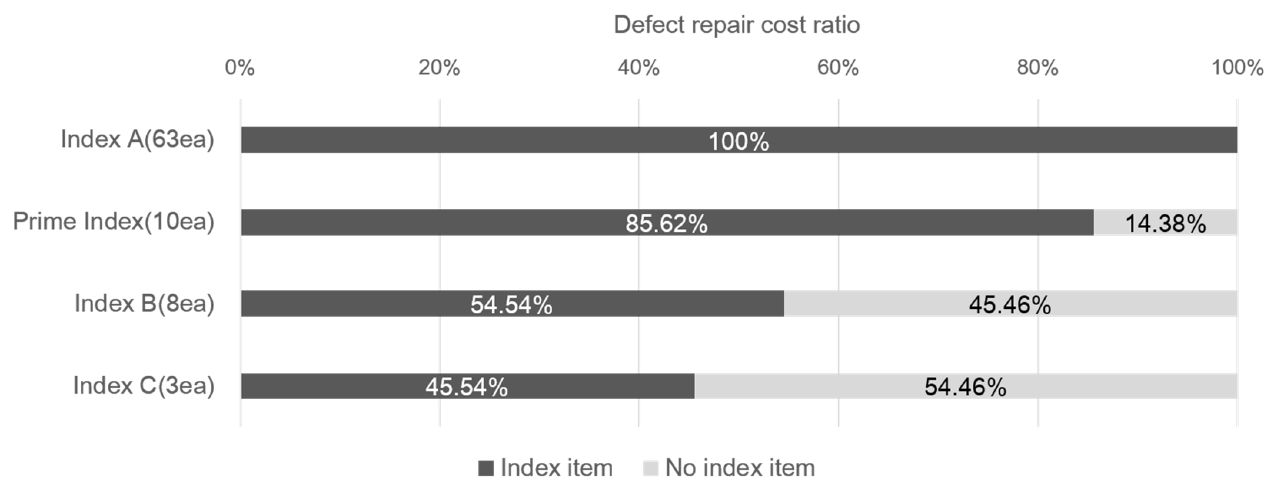
Figure 6. Comparison of defect repair cost ratio by each defect index.